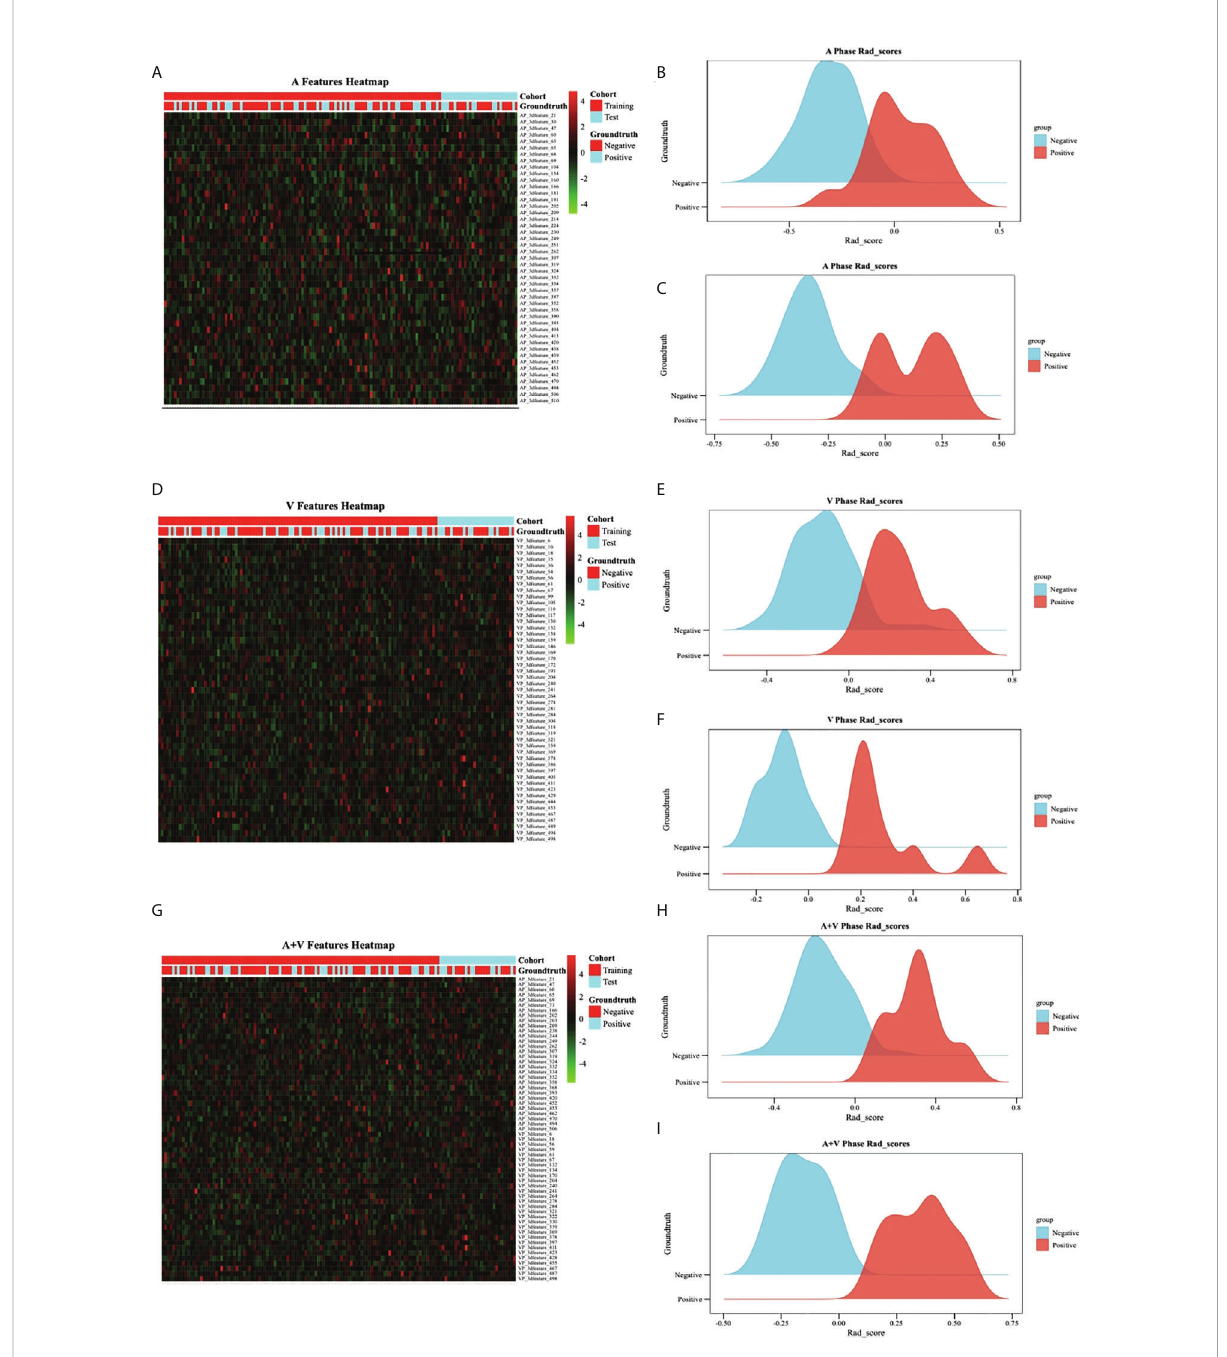
FIGURE 4 Feature heatmap and Rad score in different models. (A – C) represented AP model, and (D – F) represented VP model, and (G – I) represented AP +VP model. The heatmap is grouped according to primary group and test group. Each row corresponds to one deep learning feature, and each column corresponds to one patient. The ridgeline plot of the Rad scores in the LNM cohort (blue part) and the non-LNM cohort (orange part) showed signi fi cant difference between the two cohorts (all P